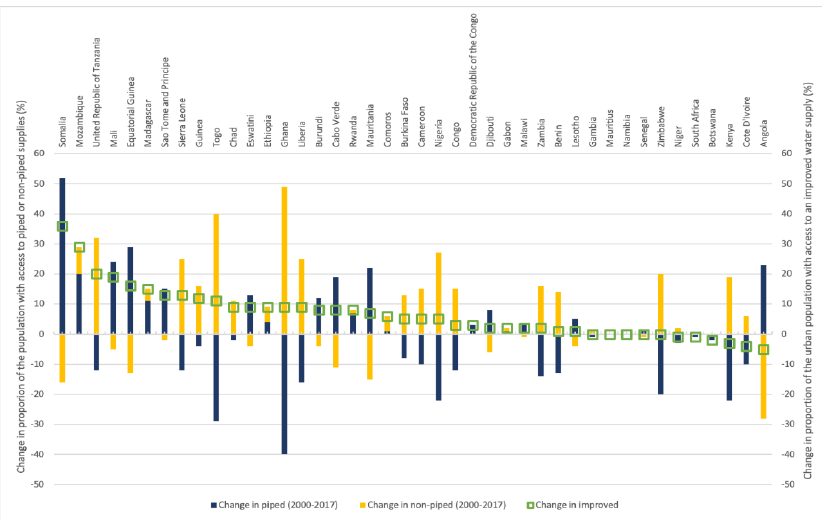
Figure 3. Change in piped and non-piped drinking water supply use as the main drinking water supply 2000 – 2017 (% urban population, by country). Source: adapted from [1].